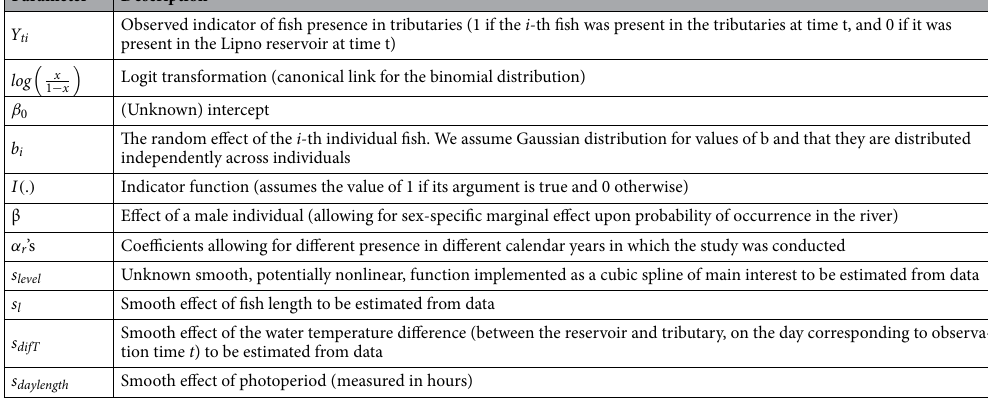
Table 2. Parameters used in the model for testing the effect of water level.